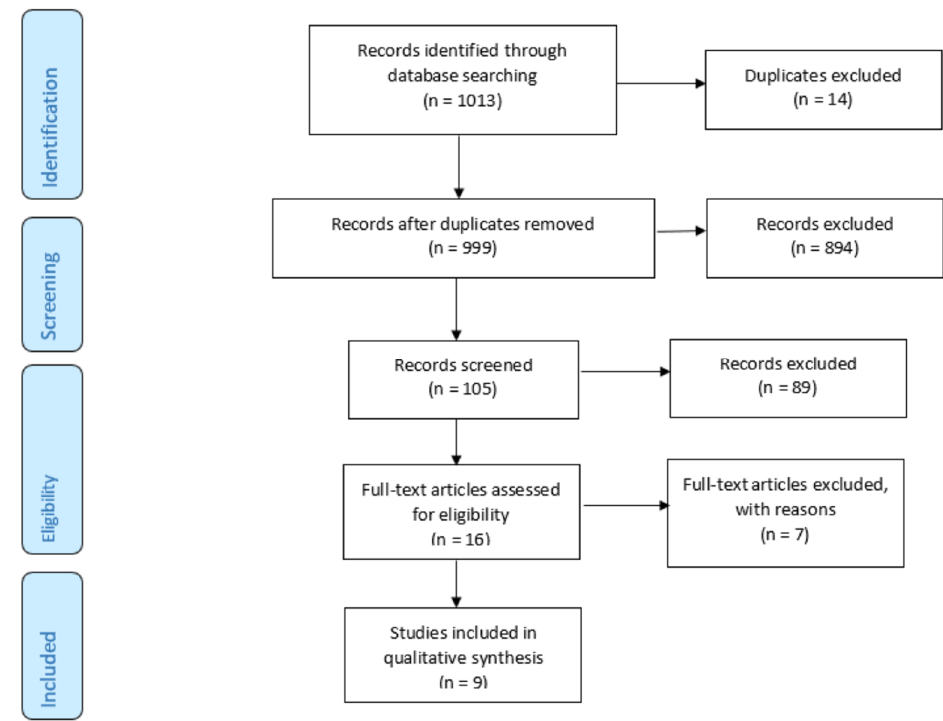
Figure 1. Included articles according to the PRISMA Guidelines.